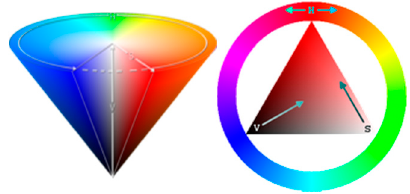
Figure 2. The HSV (hue, saturation, and value) color system.